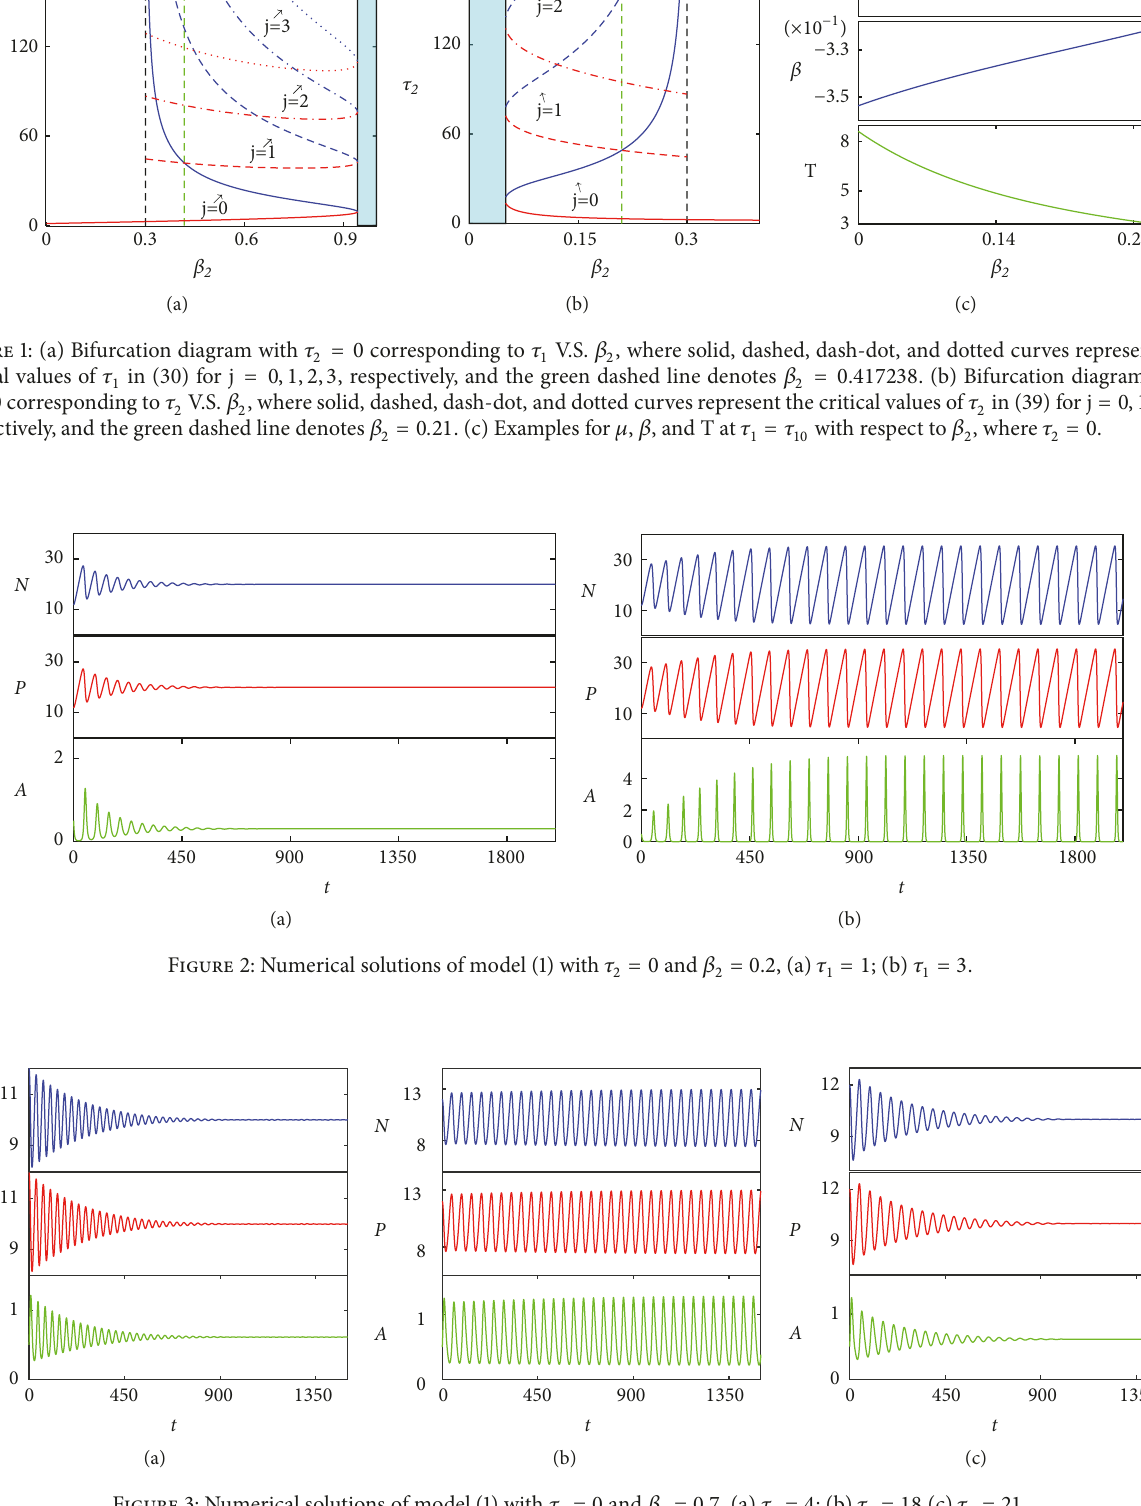
Figure 3: Numerical solutions of model (1) with 𝜏 2 = 0 and 𝛽 2 = 0.7 , (a) 𝜏 1 = 4 ; (b) 𝜏 1 = 18 (c) 𝜏 1 = 21